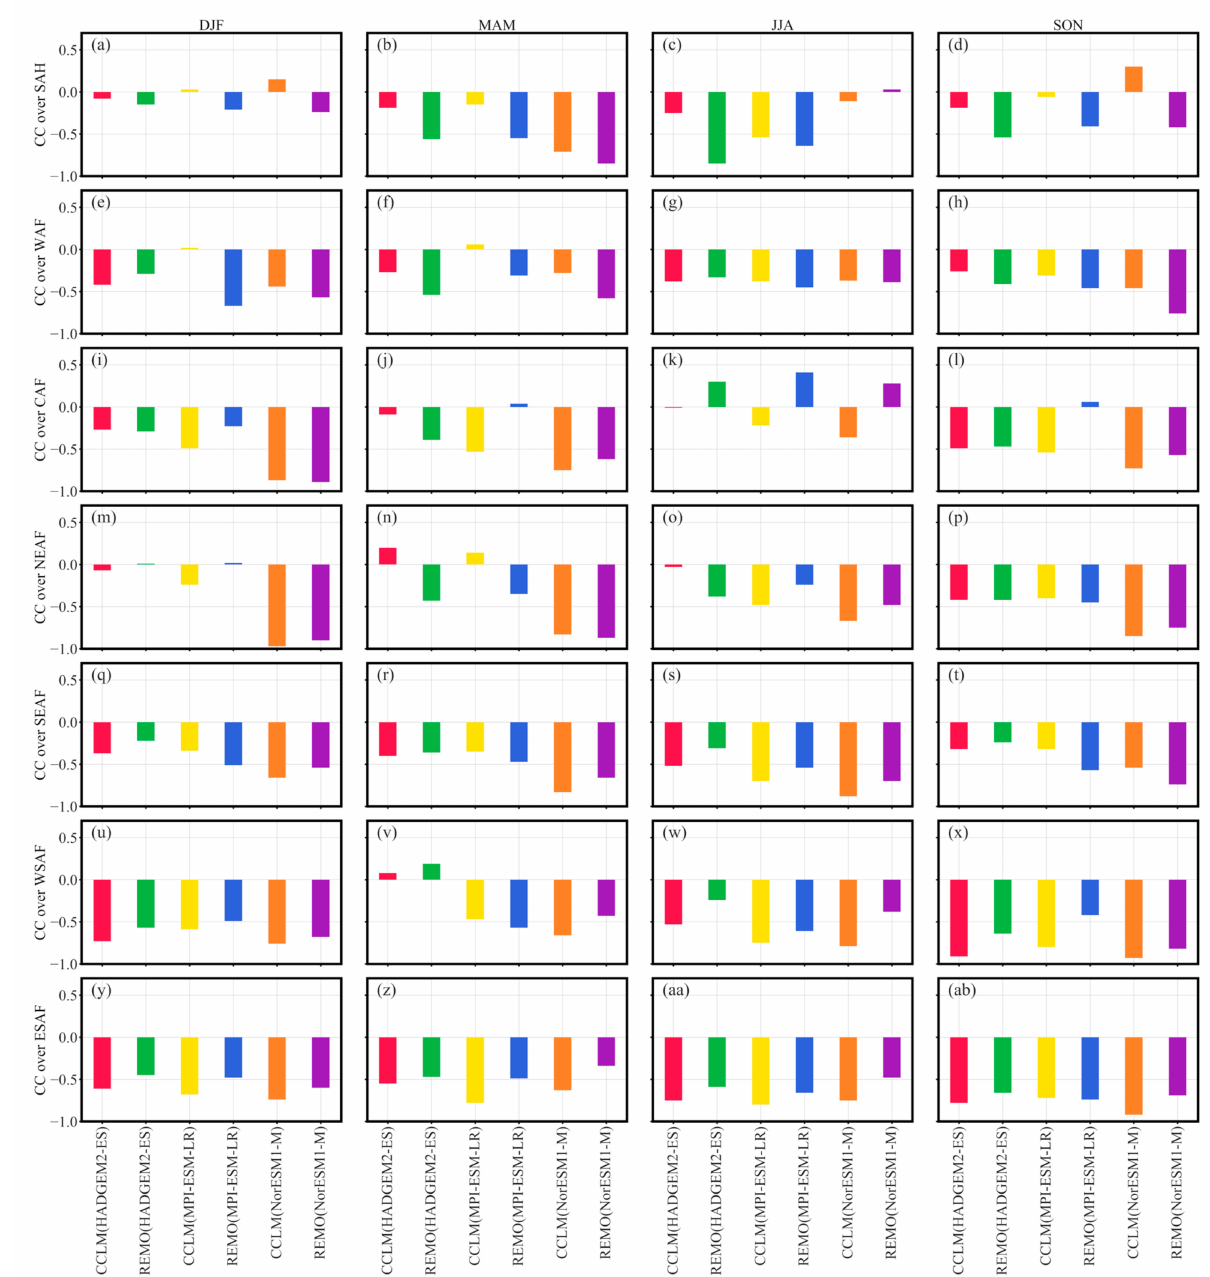
Figure 11. Correlation coefficient between the GCM/CHIRPS biases and the RCM increments over the regions indicated in Figure 1. ( a – d ) Sahara (SAH) region, ( e – h ) West Africa (WAF) region, ( i – l ) Central Africa (CAF) region, ( m – p ) Northern East Africa (NEAF), ( q – t ) Southern East Africa (SEAF), ( u – x ) Western South Africa, ( y – ab ) Eastern South Africa